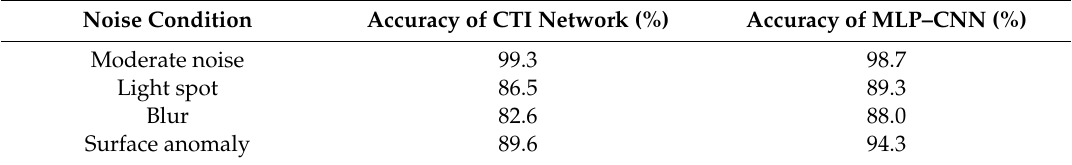
Table 5. Accuracy of crack type identification under di ff erent noise types and